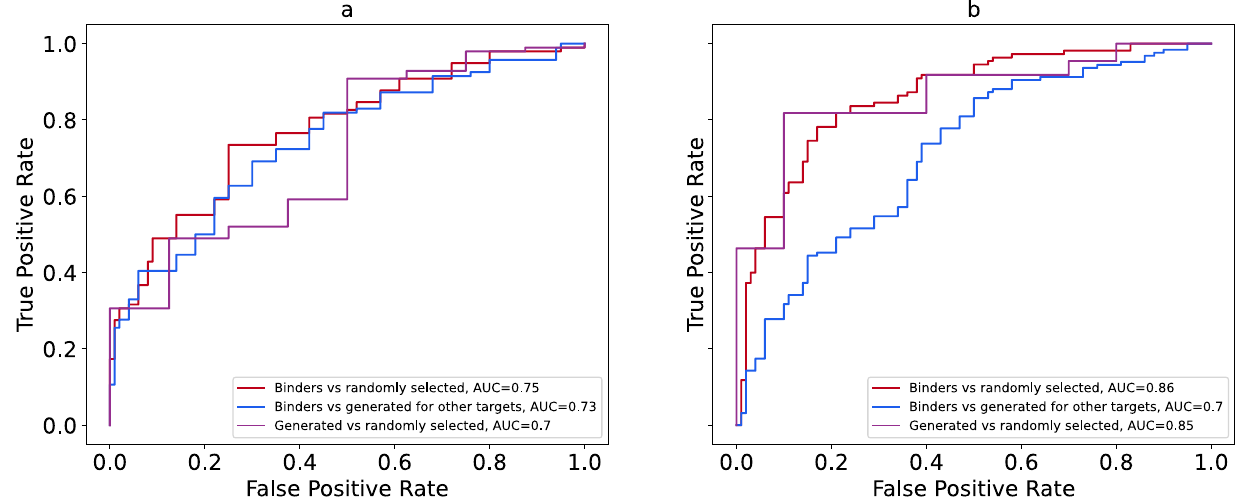
Figure 2. ROC curves and corresponding AUC for the following structures: ( a ) structure of IGF-1R with PDB code 3O23, ( b ) structure of VEGFR2 with PDB code